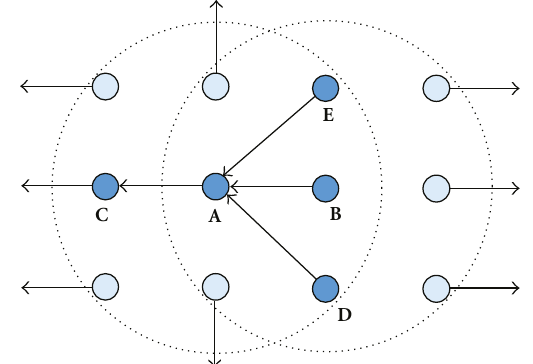
Figure 7: Network topology for channel access comparison.